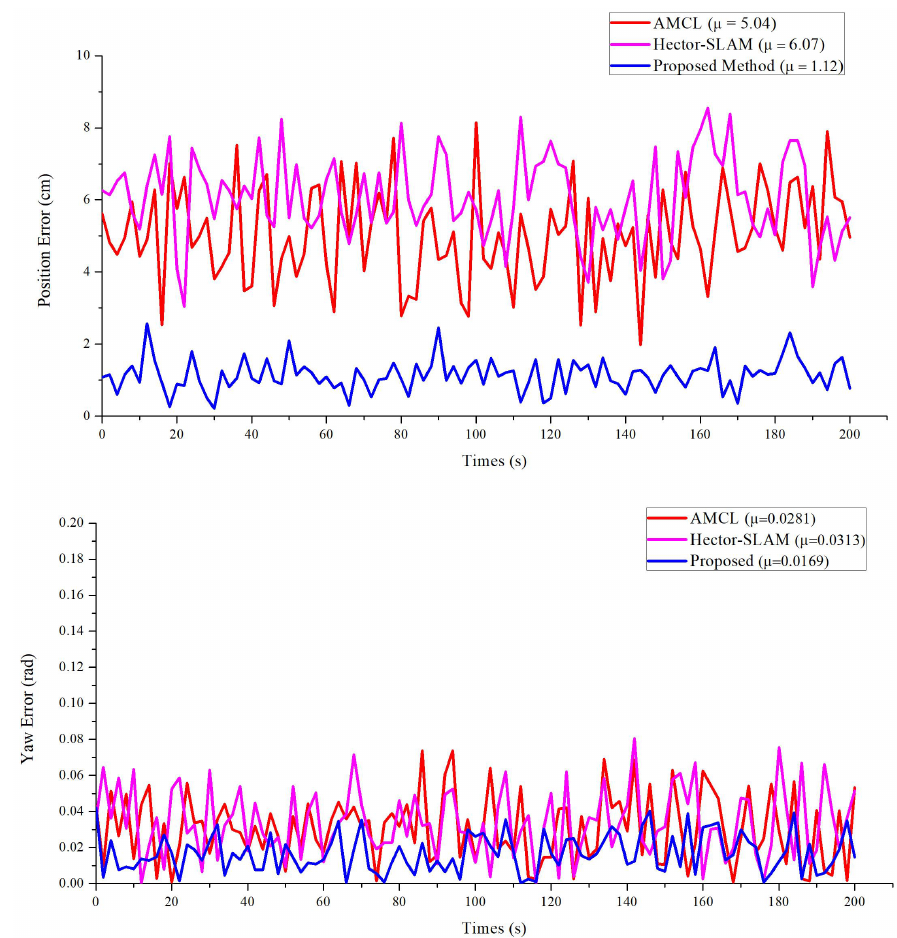
Figure 9. Comparison between the proposed method with AMCL and Hector SLAM. ( a ) Position Error vs. Time, ( b ) Yaw Error vs.